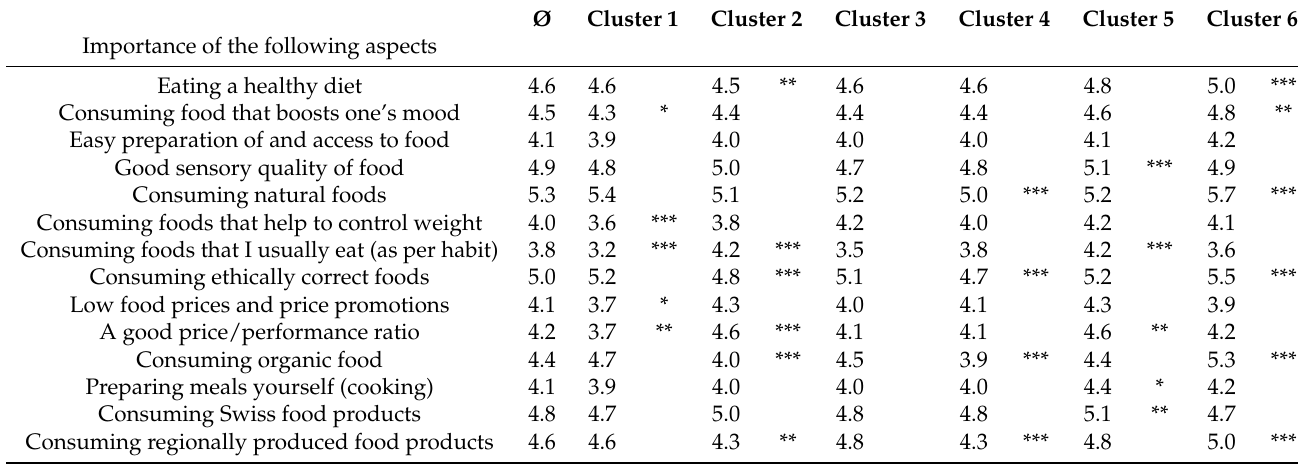
Table 4. Comparison of clusters with regard to other diet- and food consumption-related attitudes, preferences and behavioural variables.